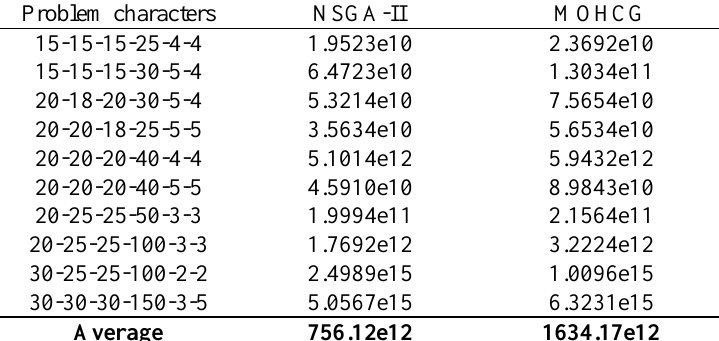
Table 8 . SC measure for medium/large-sized instances Problem characters